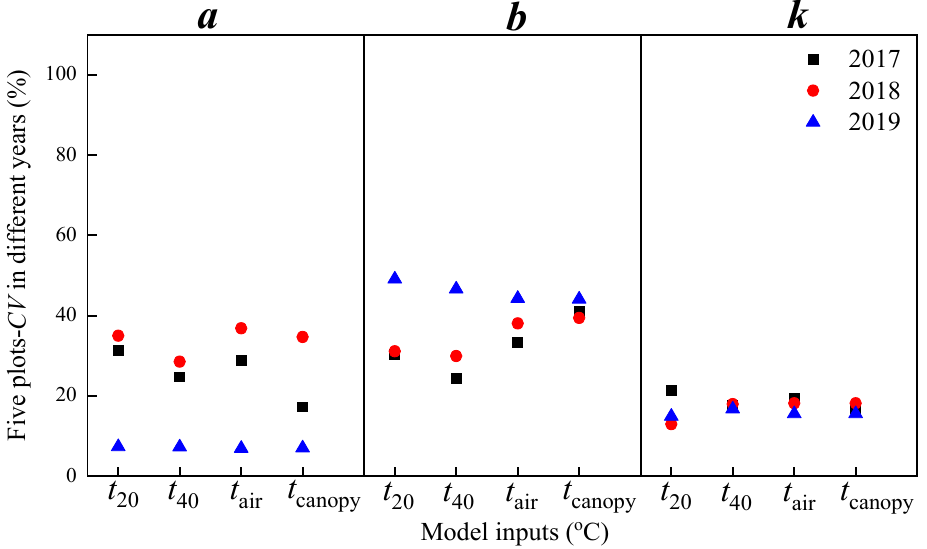
Figure 8. The performance of the DBA simulation results based on the logistic models. ( a ) Average values of R 2 of DBA simulating at five plots based on the logistic model with four kinds of effective accumulated temperature in 2017, 2018, and 2019; ( b ) DBA simulating in five plots based on the logistic model with effective accumulated canopy temperature ( t canopy ) in 2017.